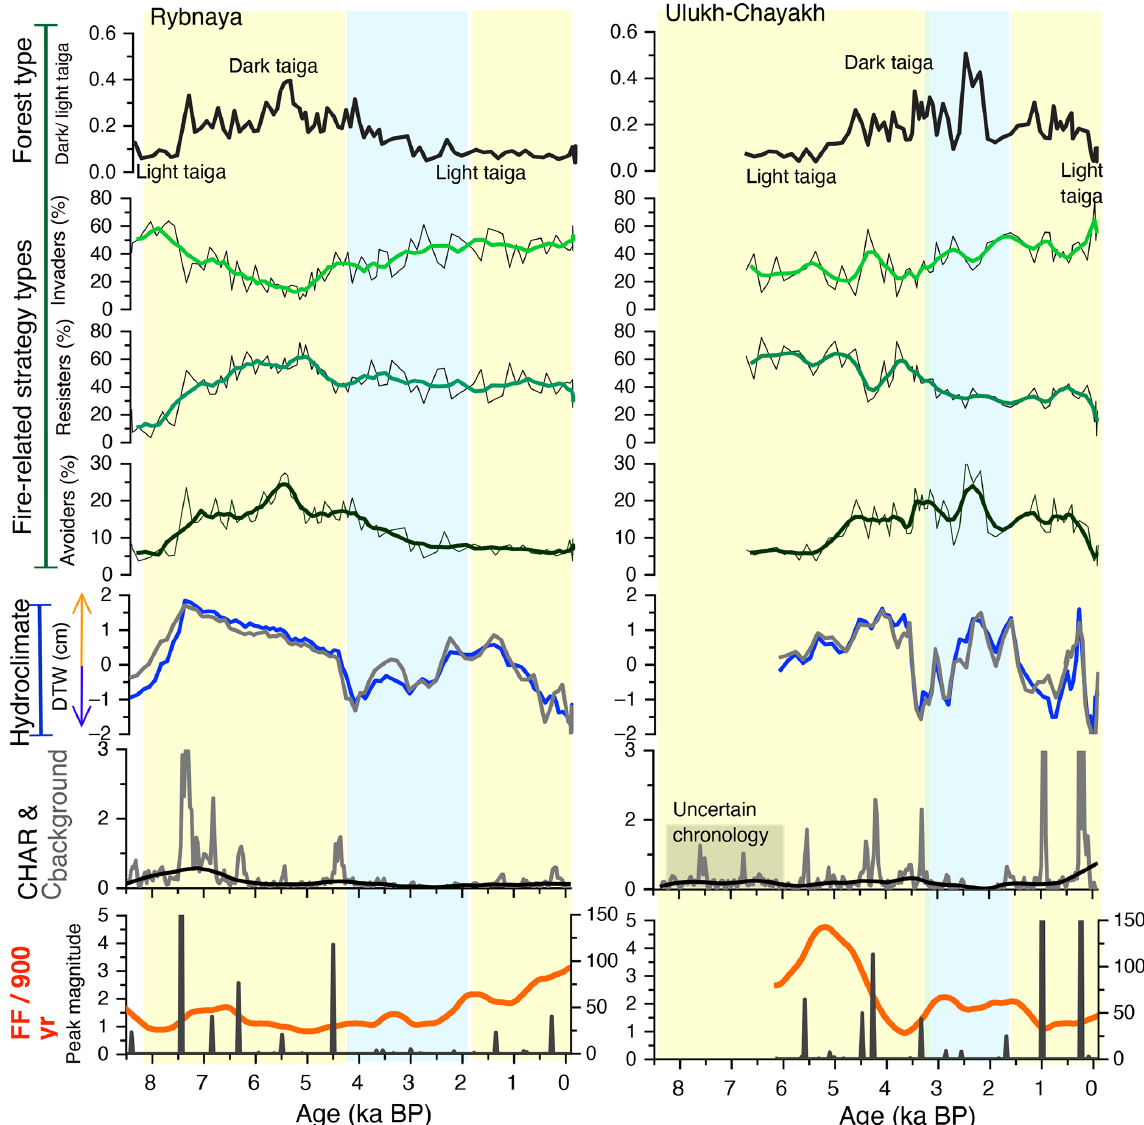
Figure 4. Temporal trends in the pollen percentages of the fire-related plant functional groups (invaders, resisters, and avoiders) and the forest type determined from the ratio between pollen percentages of dark and light taiga tree taxa in the Rybnaya and Ulukh–Chayakh sequences. Hydrological conditions of the peatlands were derived from testate-amoeba-based estimates of the water table depth using the European transfer function (blue) and the Asia transfer function (grey); positive Z -score values represent greater-than-mean water table (deep water table), and negative Z -score values represent lower-than-mean water level (shallow water table). The fire metrics include burned biomass (CHAR), fire frequency (number of fires per 900 years), and charcoal peak magnitude (the higher the values, the greater the fire severity and/or the closer to the site) derived from macrocharcoal particles > 150µm. Colours in the background denote periods with marked changes in fire regime and vegetation composition; a change from blue to yellow indicates an intensification of the fire